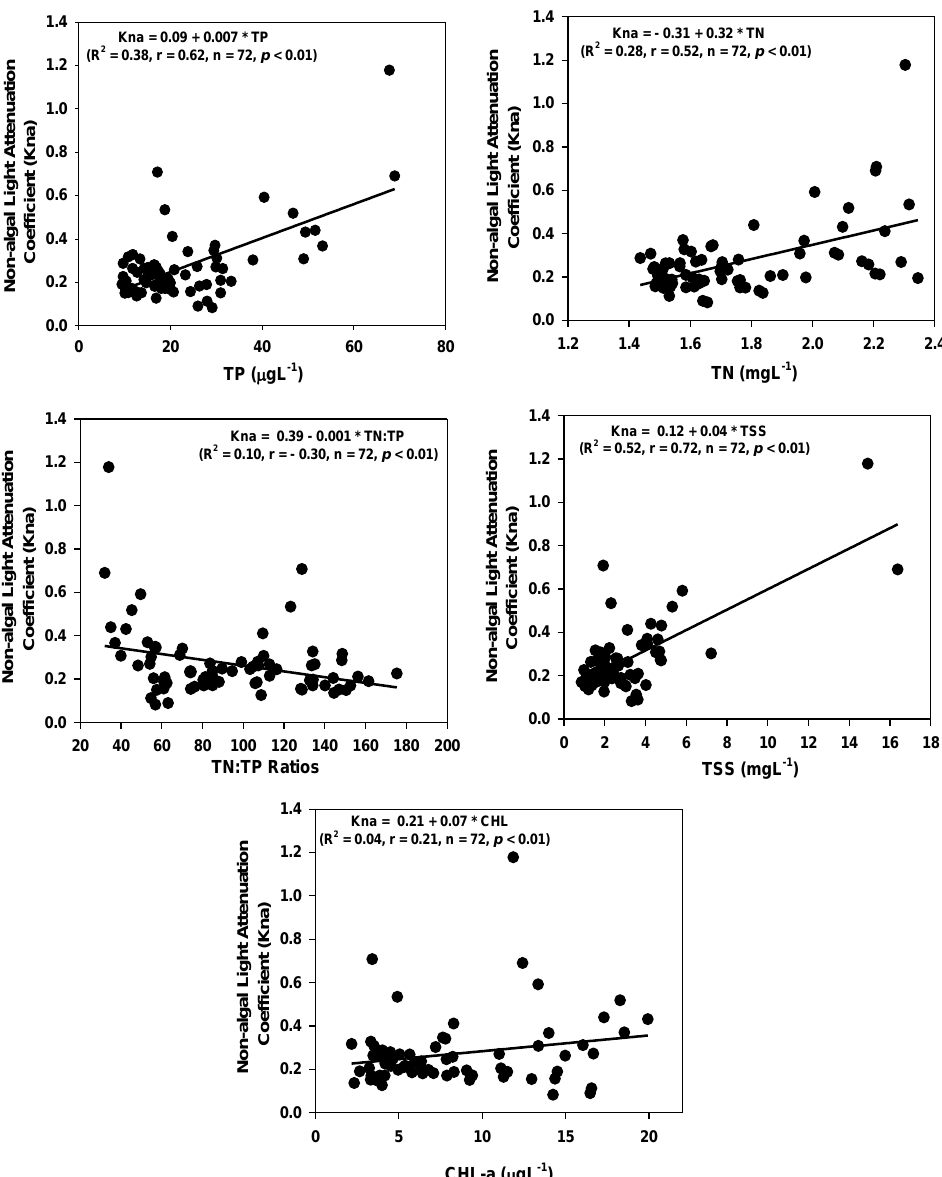
Figure 6. Relations among non-algal light attenuation coefficient (Kna) with nutrients (TP: total phosphorus, TN: total nitrogen), total suspended solids (TSS) and chlorophyll-a (CHL-a) in the Daecheong Reservoir. Average water quality data used from 2000–2018.